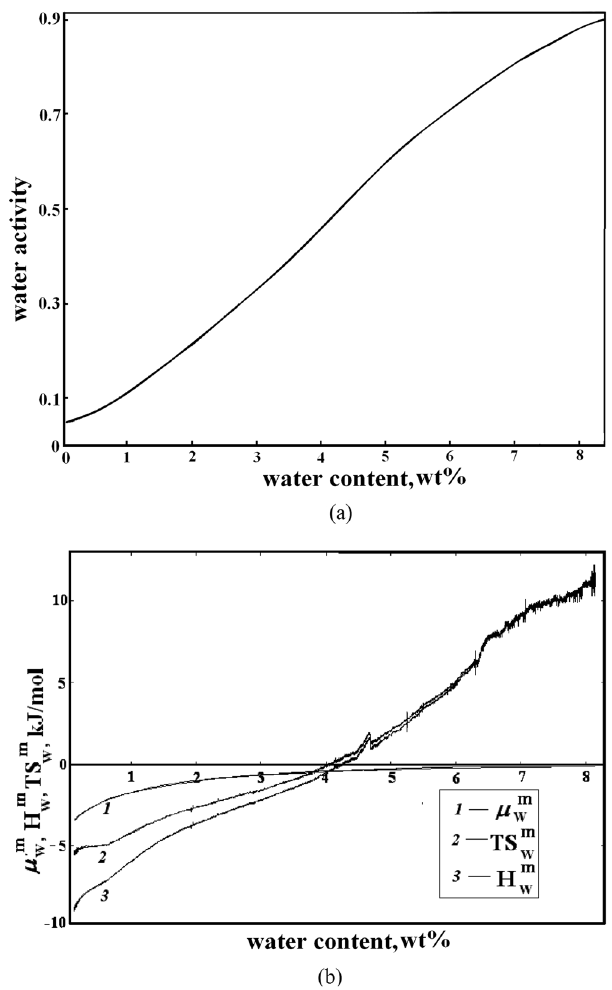
of water mixing ( b ) for PAIU